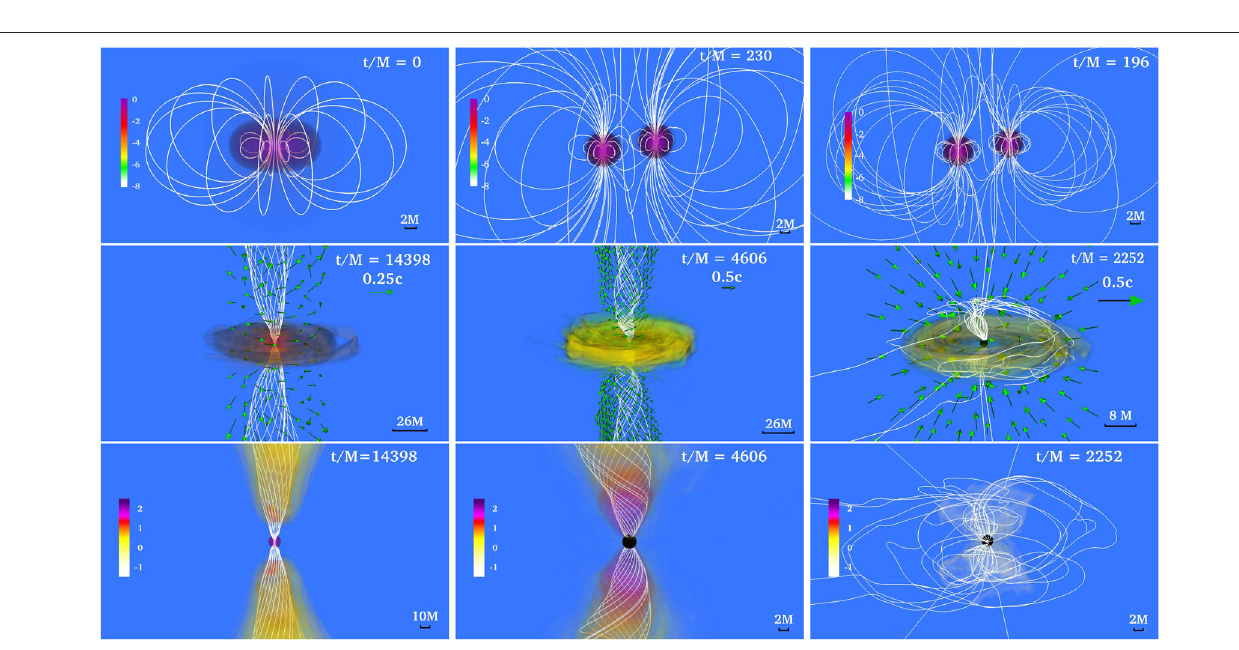
FIGURE 9 | NS rest-mass density ρ 0 normalized to its initial maximum value (log scale) for a NSNS binary that forms: a stable, supramassive remnant (left) ; a HMNS remnant that undergoes delayed collapse (middle) ; and a remnant that undergoes prompt collapse (right) . Top row displays the NSs at the time of magnetic field insertion, while middle row displays the outcome once the remnant has reached quasi-equilibrium. Bottom row shows the force-free parameter B 2 / (8 πρ 0 ) (log scale). White lines represent magnetic field lines, while arrows represent fluid velocity flow vectors. The field lines form a tightly wound helical funnel and drive a jet following delayed collapse, but not in the other two cases. Here M = 0.0136( M tot / 2.74 M ⊙ )ms = 4.07( M tot / 2.74 M ⊙ )km; therefore quasi-equilibrium for the supramassive case (left column) is achieved at t ∼ 200 ms (from Ruiz et al.,